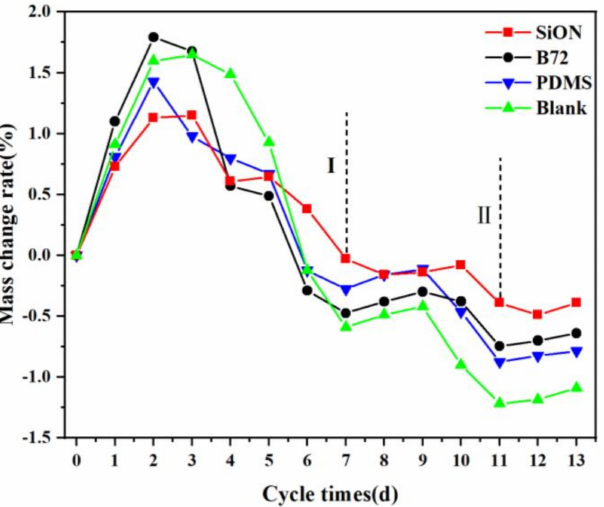
Figure 7. The mass change rate of sandstone coated with different materials after weathering cycles: (I) the first stage of salt weathering; (II) the second stage of salt weathering. After the salt weathering cycle experiment, the mass loss rates of samples SiON, B72, PDMS, and Blank were 0.392%, 0.642%, 0.781%, and 1.09%, respectively. The small